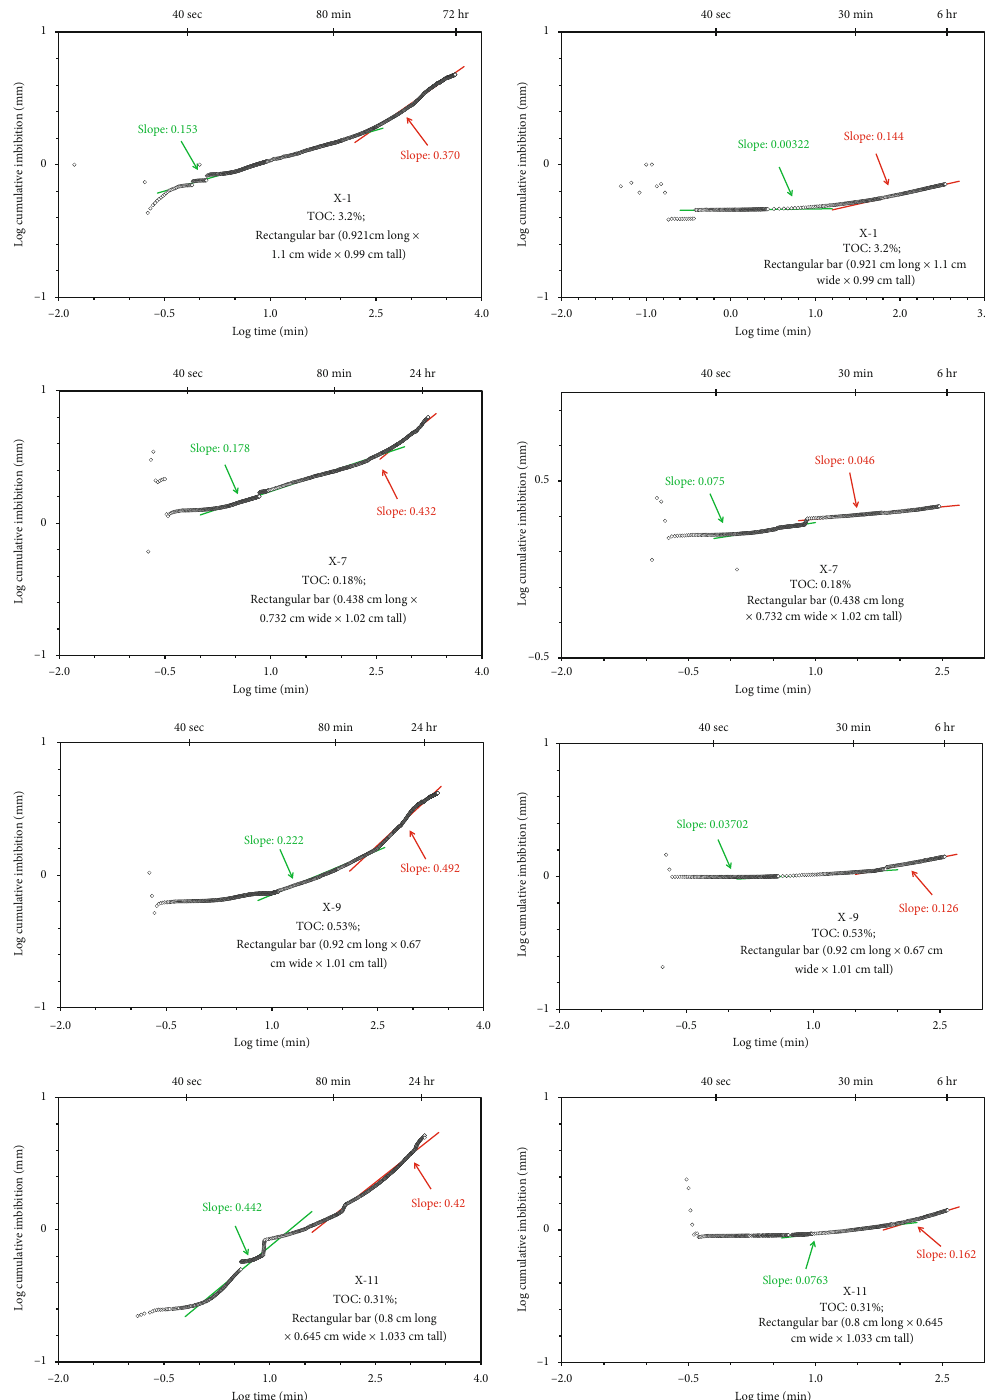
Figure 13: Log-log plots of cumulative elapsed time vs. fl uid imbibition (DIW: left panel; 2DT: right connectivity. Figure 12 shows that the second slopes for The second imbibition slopes (shown as red colors) in DIW imbibition in the “ low TOC layered clayey mudstone ” the log-log plots are used to quantitatively assess mudstone ’ s and “ low TOC massive siliceous mudstone ” facies are 0.49 pore connectivity according to the percolation theory [13], and 0.42, respectively, suggesting that the hydrophilic pore and a classical behavior of 0.5 slope value represents high networks have a good connectivity in mm-scale sample sizes. pore connectivity and a slope of 0.26 – 0.5 for intermediate The hydrophilic pores of the “ high TOC laminated clayey pore connectivity; the slope below 0.26 means low pore